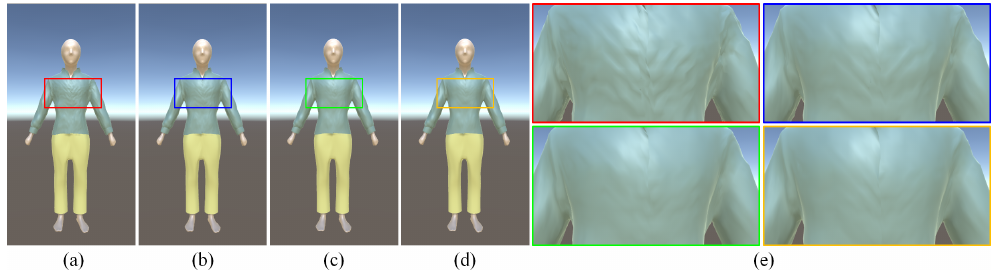
Figure 6. Effect of neighborhood size k : ( a ) k = 1; ( b ) k = 3; ( c ) k = 6; ( d ) k = 10; ( e ) zoom in.